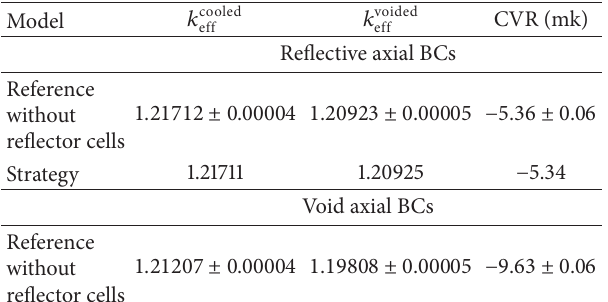
Table 1: Channel multiplication factors and CVRs for models without axial reflector cells.